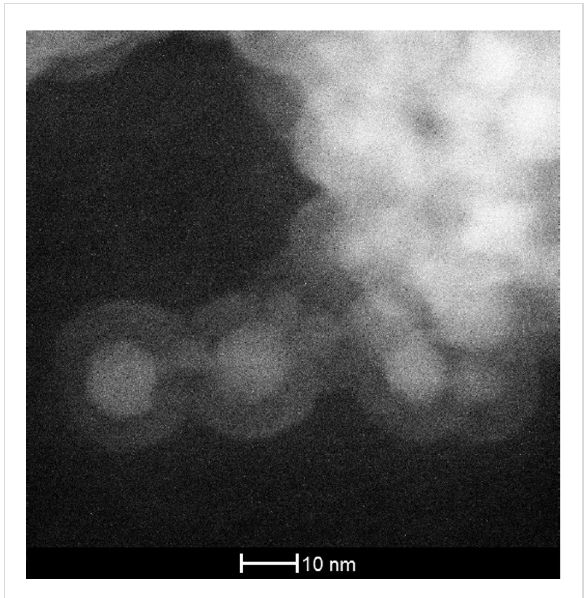
Figure 7: STEM image of TiO 2 :Eu nanoparticles coated with a shell of 3 nm Al 2 O 3 and TiO 2 .